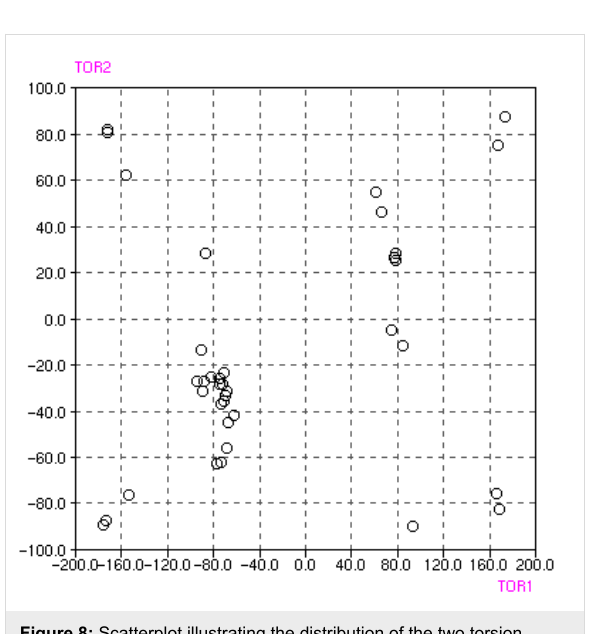
Figure 8: Scatterplot illustrating the distribution of the two torsion angles (C4-C5-C7-C8 (TOR1) and C5-C7-C8-C9 (TOR2)) that describe the mutual orientation of pyrimidine and phenyl rings in the TMP molecule. The torsion angle values were obtained from the July 2003 release of the 5.24 version of the CSD [32]. The values of TOR2 have been restricted to the range from -90 to +90°.